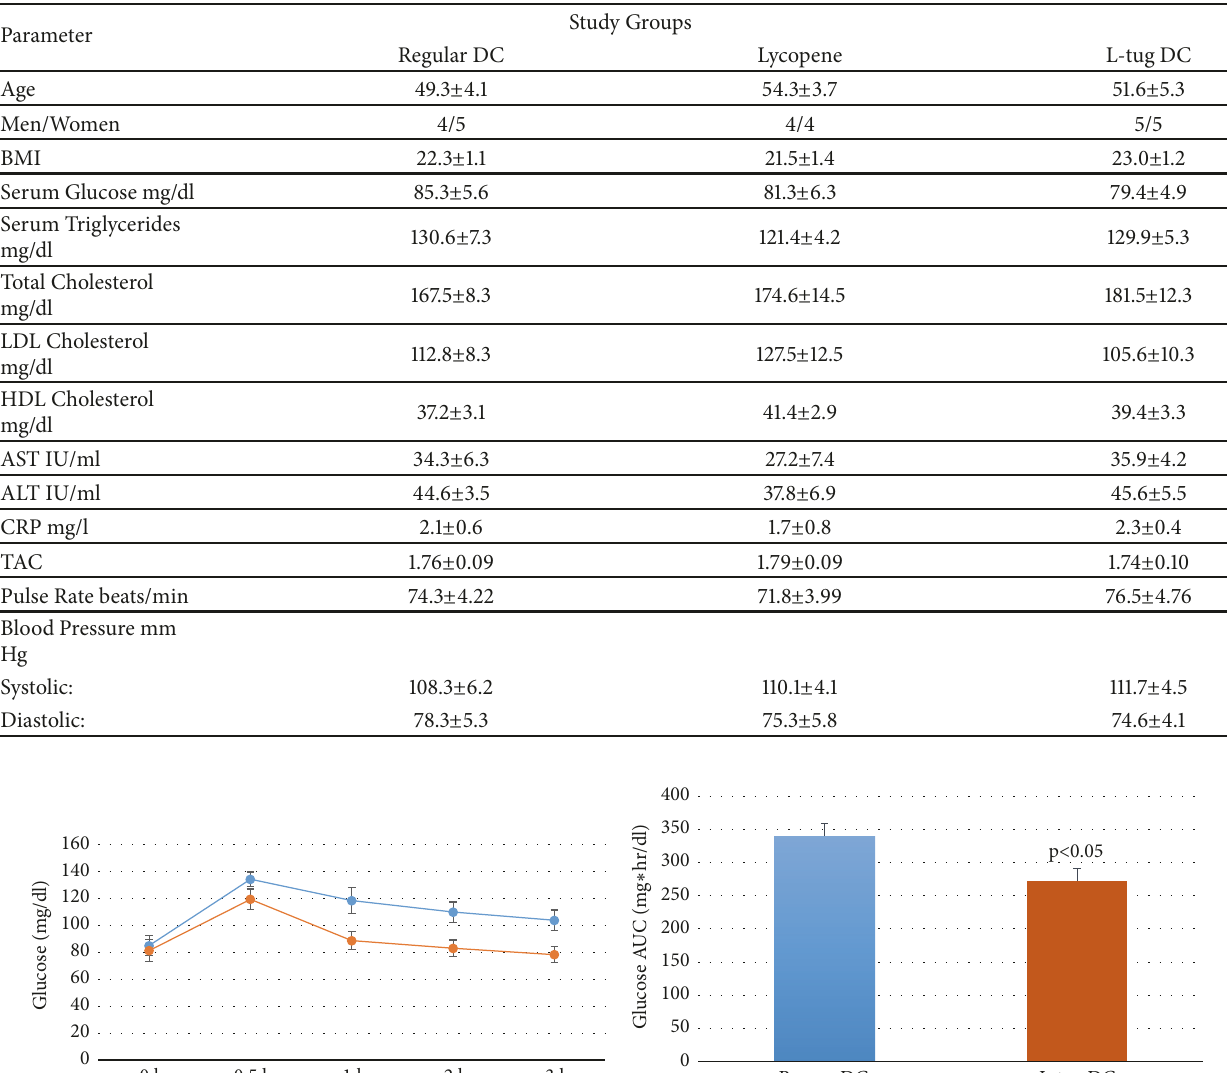
Table 1: Baseline values of fasting study participants (averages ± SD).